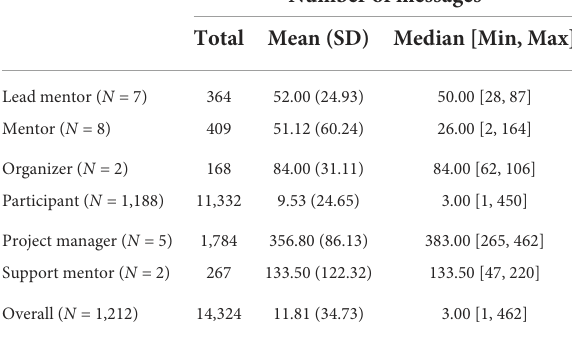
TABLE 1 Data-set descriptors-user data ( N = number of users with that